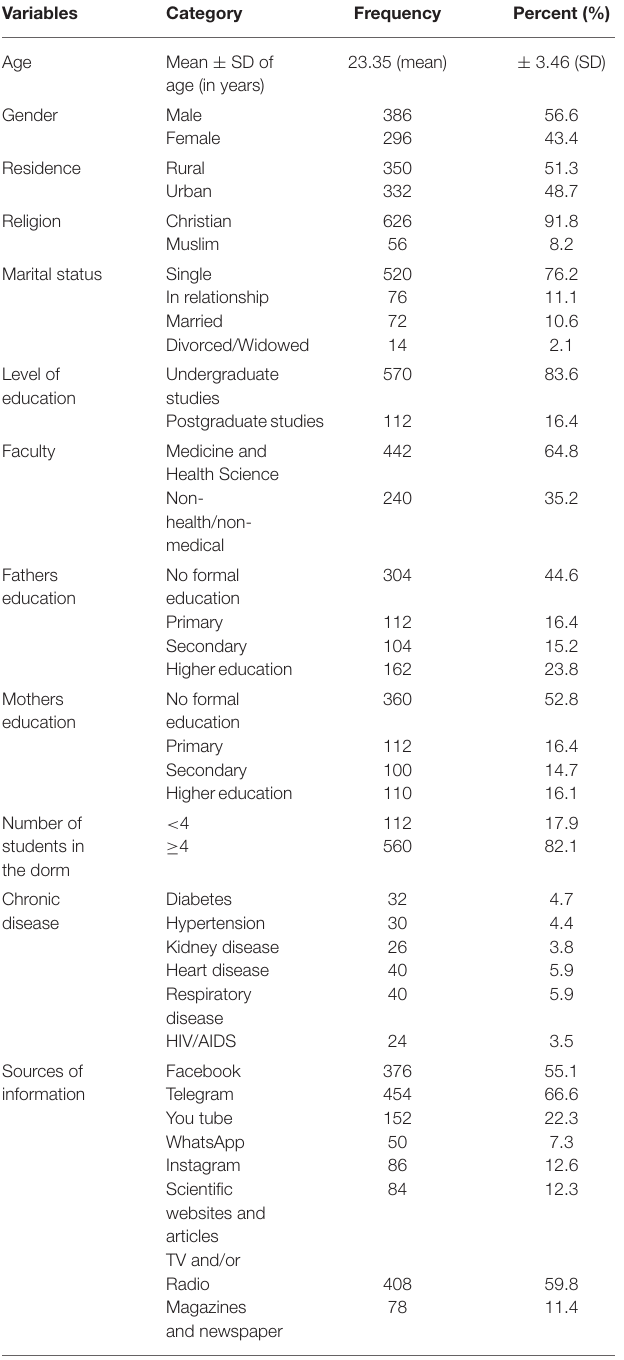
TABLE 1 | Respondents baseline characteristics, 2020. TABLE 2 | Perception of national efforts at controlling the COVID-19 pandemic among university students, 2020.